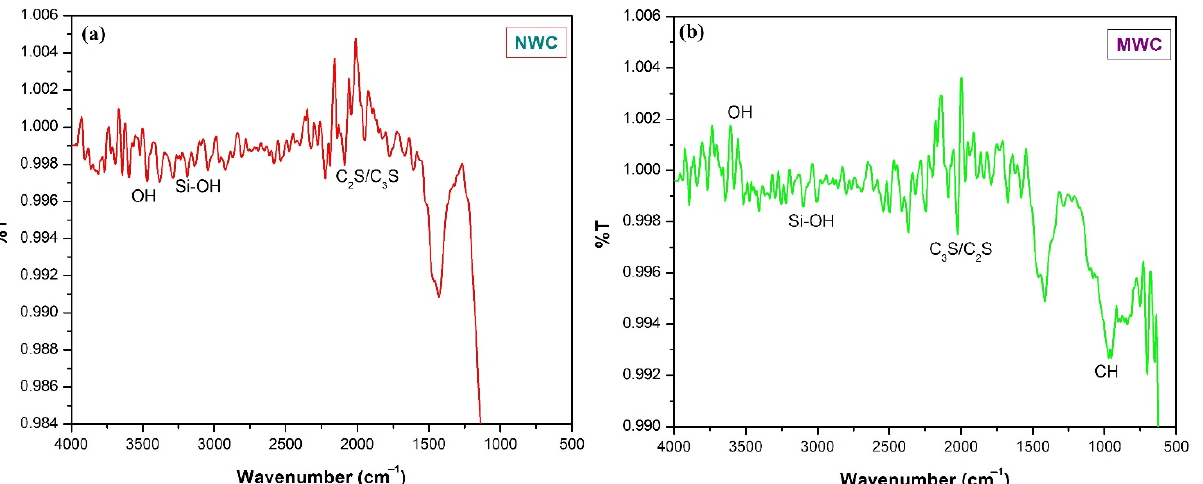
Figure 10. TGA curves for NWC and MWC.